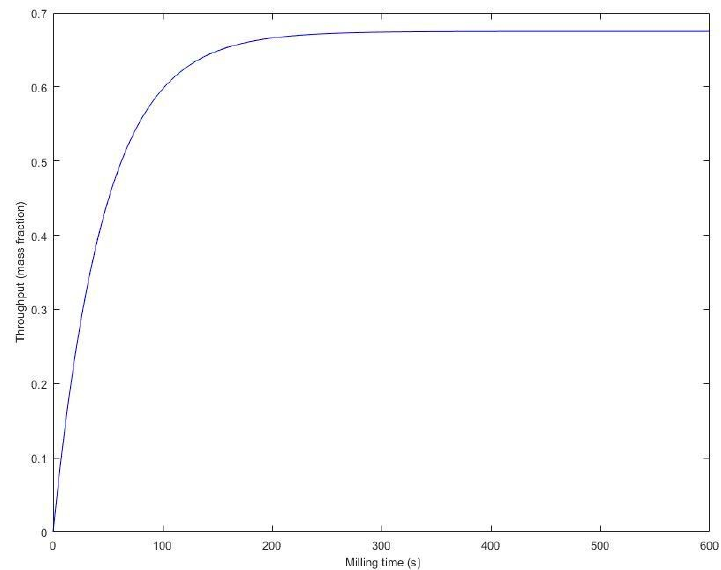
Figure 1. Typical mass throughput profile of a Comil. The graph represents a 600 g batch loading and an impeller speed of 3000 rpm.